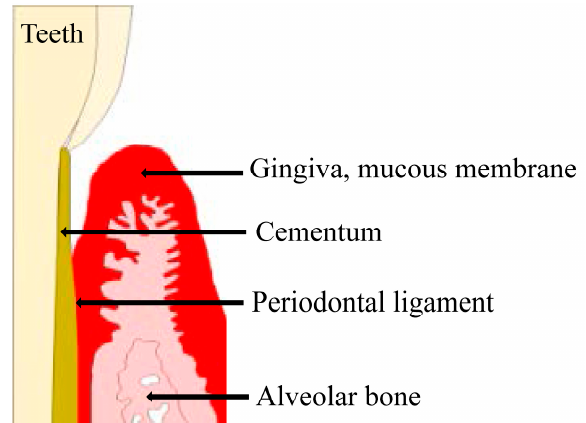
Figure 1. The investing and supporting structures of the teeth consist of the attachment apparatus, which includes the root cementum, periodontal ligament, alveolar process, gingiva, and mucous membrane covering. These tissues are collectively referred to as the periodontium.